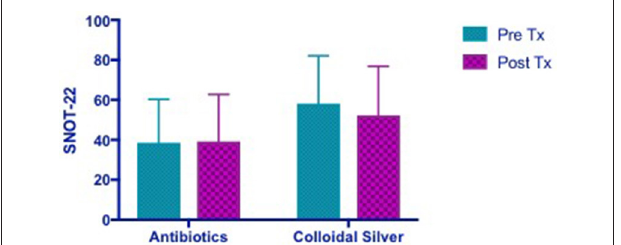
FIGURE 3 | Bar graph showing no change in SNOT-22 scores in CON group, while CS group showed a trend of improved SNOT-22 scores, but not statistically significant. SNOT-22, Sino-Nasal Outcome Test-22; CON, Control; CS, Colloidal silver.